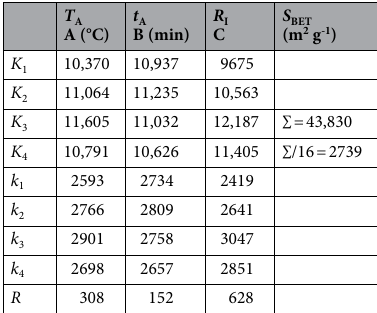
Table 4. The range analysis of specific surface area.